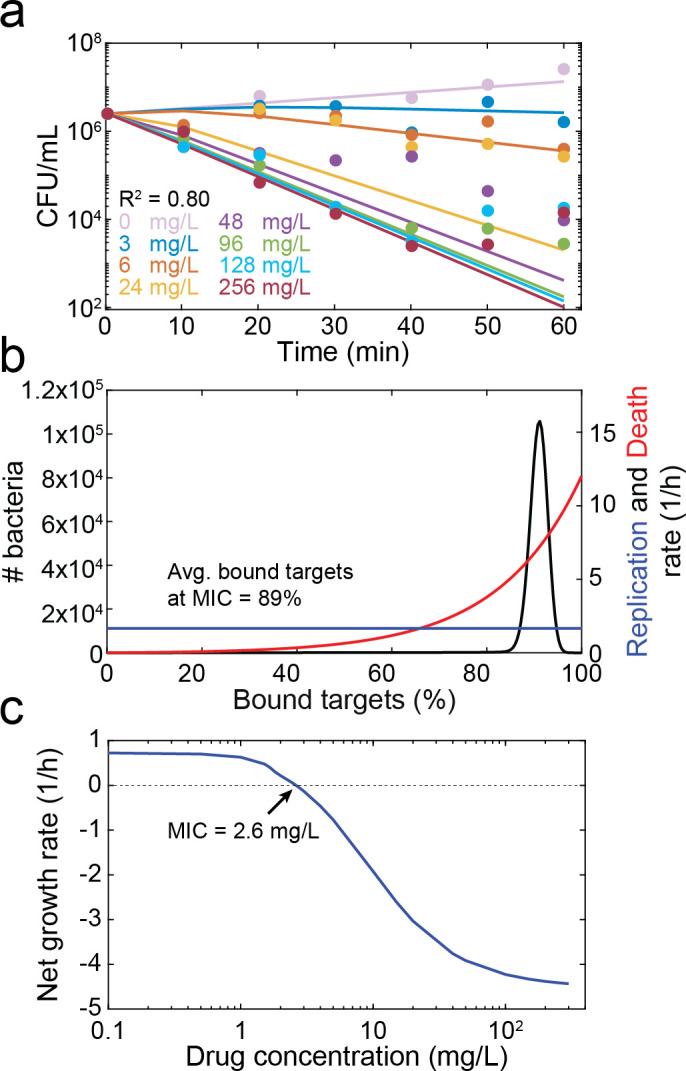
Model prediction of MIC and target occupancy at MIC for ampicillin.a, Model fit to previously published time-kill curves [34]. The points represent experimental data, and the lines represent the fit of the model. Each color indicates a single ampicillin concentration, as described in the legend. b, Replication (blue) and death (red) rates as a function of the number of bound targets predicted by the model fit in (a). The black line indicates the predicted distribution of target occupancies in a bacterial population (both living and dead cells) exposed to ampicillin at the MIC for 18 h. c, The net growth rate, as determined by the slope of a line connecting the initial bacterial density and the bacterial density at 18 h on a logarithmic scale predicted from the model fit in (a), is shown as function of the drug concentration (blue). The dotted horizontal line indicates zero net growth, and the intersection with the blue line predicts the MIC (2.6 mg/mL).